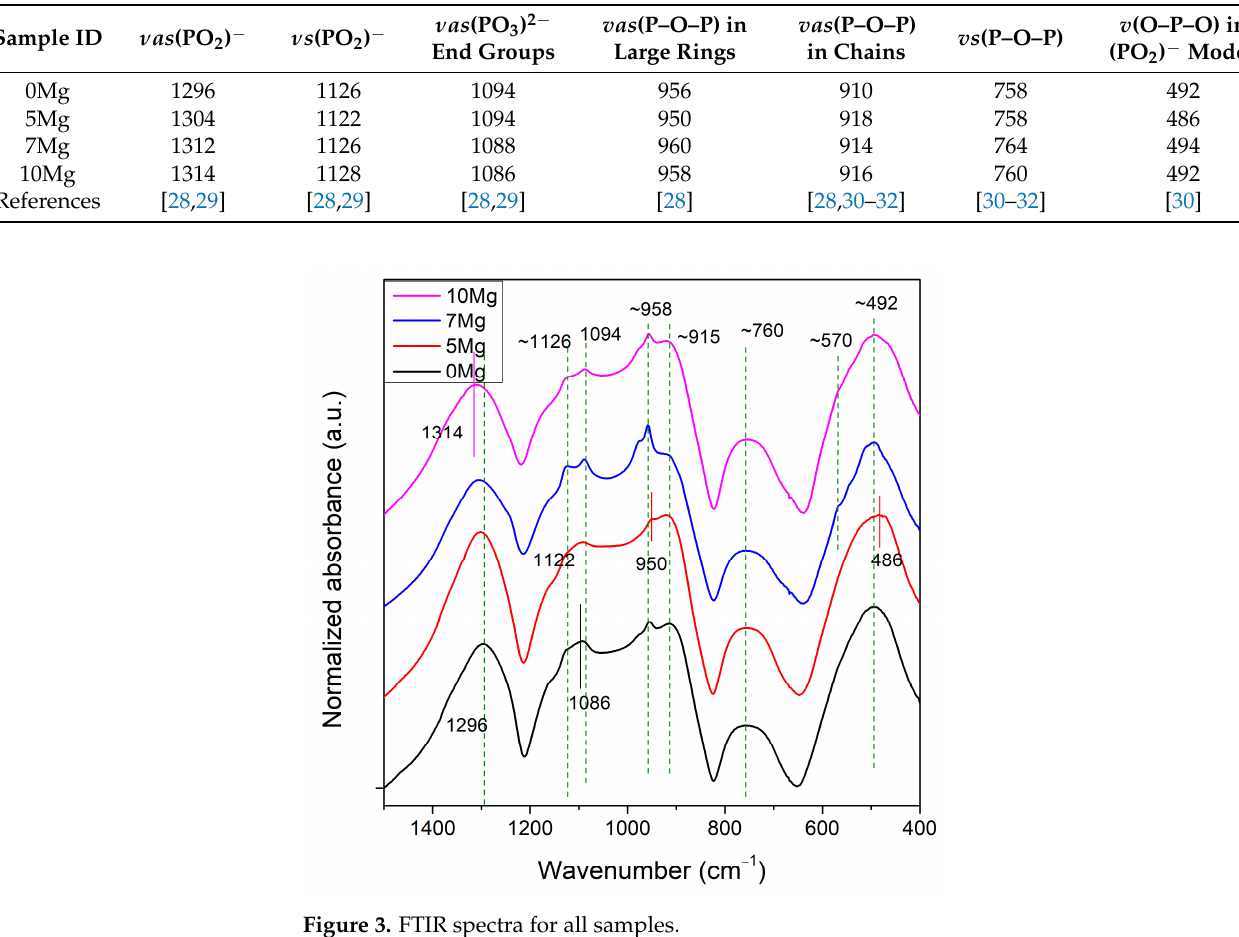
Figure 3. FTIR spectra for all